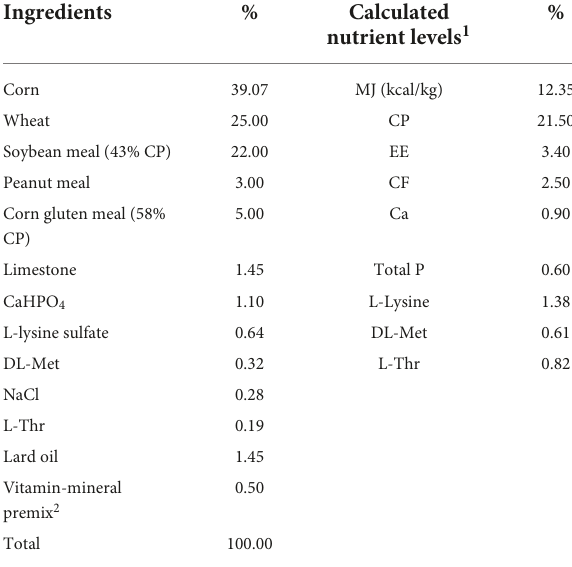
TABLE 1 The composition and nutrient levels of the basal diet for yellow-feathered